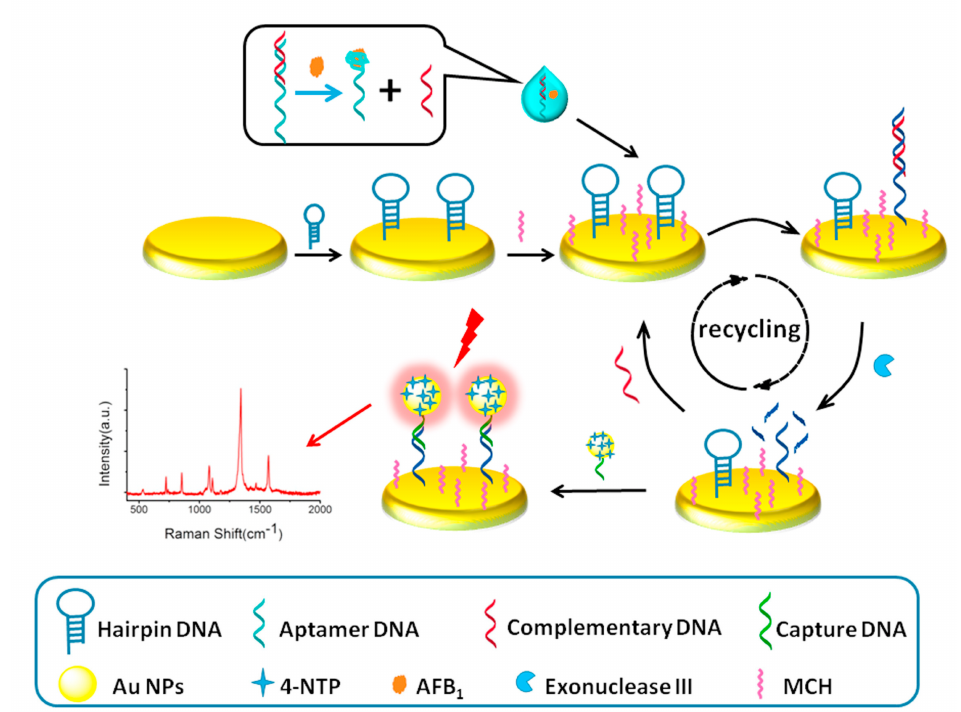
Figure 7. A recycling SERS-based aptasensor chip using the exonuclease to amplify the Raman signal